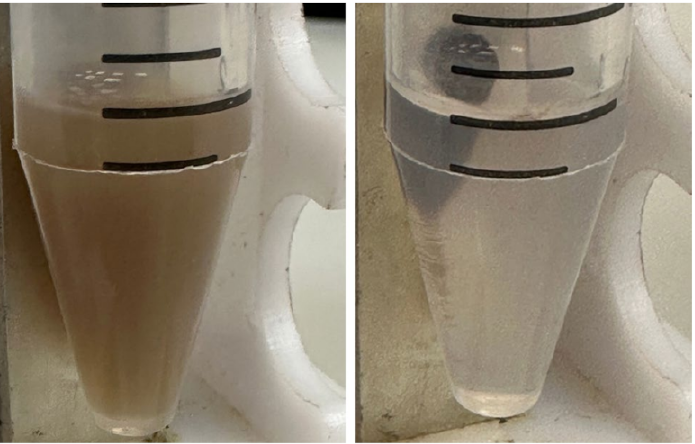
Figure 3. Magnetic separation of Fe 3 O 4 @CaCO 3 nanocomposite (0.45 mg/mL of Fe 3 O 4 synthesis) immediately ( left ) and after 15 s ( right